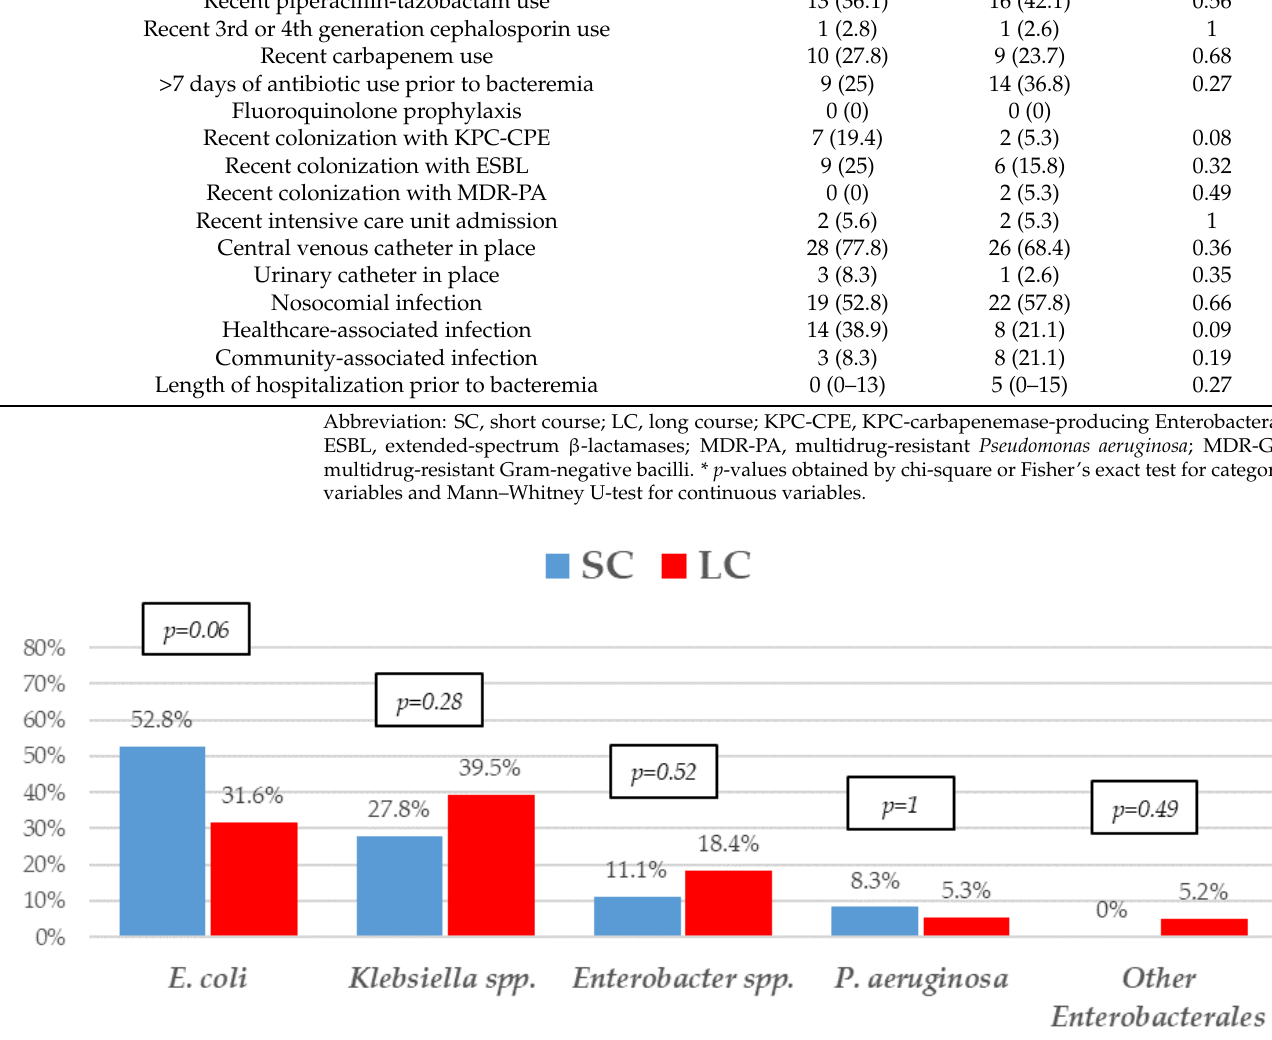
Figure 2. Resistance mechanisms of Gram-negative bacilli bacteremia treated with short-course (SC) or long-course (LC) antibiotic therapy. The proportion of extended- spectrum β -lactamases (ESBL), KPC carbapenem-producing ( bla KPC), and multidrug-resistant Pseudomonas aeruginosa. p -values ob- tained by Fisher ’ s exact test.